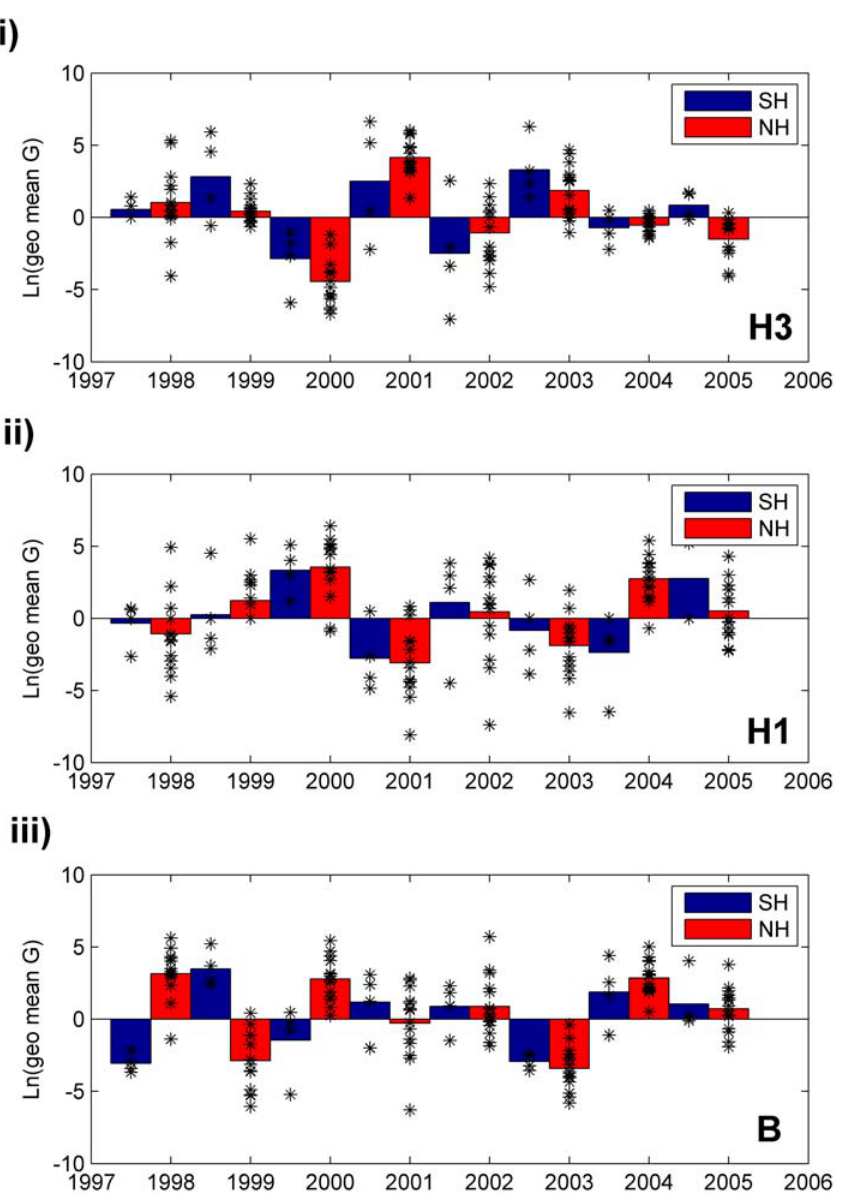
Figure 4. Annual type and subtype epidemic growth rates by hemisphere. The epidemic growth rate ( G ) was calculated for each country by dividing the annual sum of adjusted weekly isolates for year ‘‘t’’ by the sum for year ‘‘t-1.’’ The average value of G for each hemisphere was determined by taking the geometric mean of the individual country values. To emphasize the difference between positive and negative growth, the natural log of the growth rates were plotted for (i) H3, (ii) H1, and (iii) B. The scatter plot shows the values of G for individual countries in the given season, to give an idea of the observed variation. Note that the values for 1998 and 1999 in the Southern Hemisphere are based on only three countries, as Argentina had no data available during the 1998 influenza